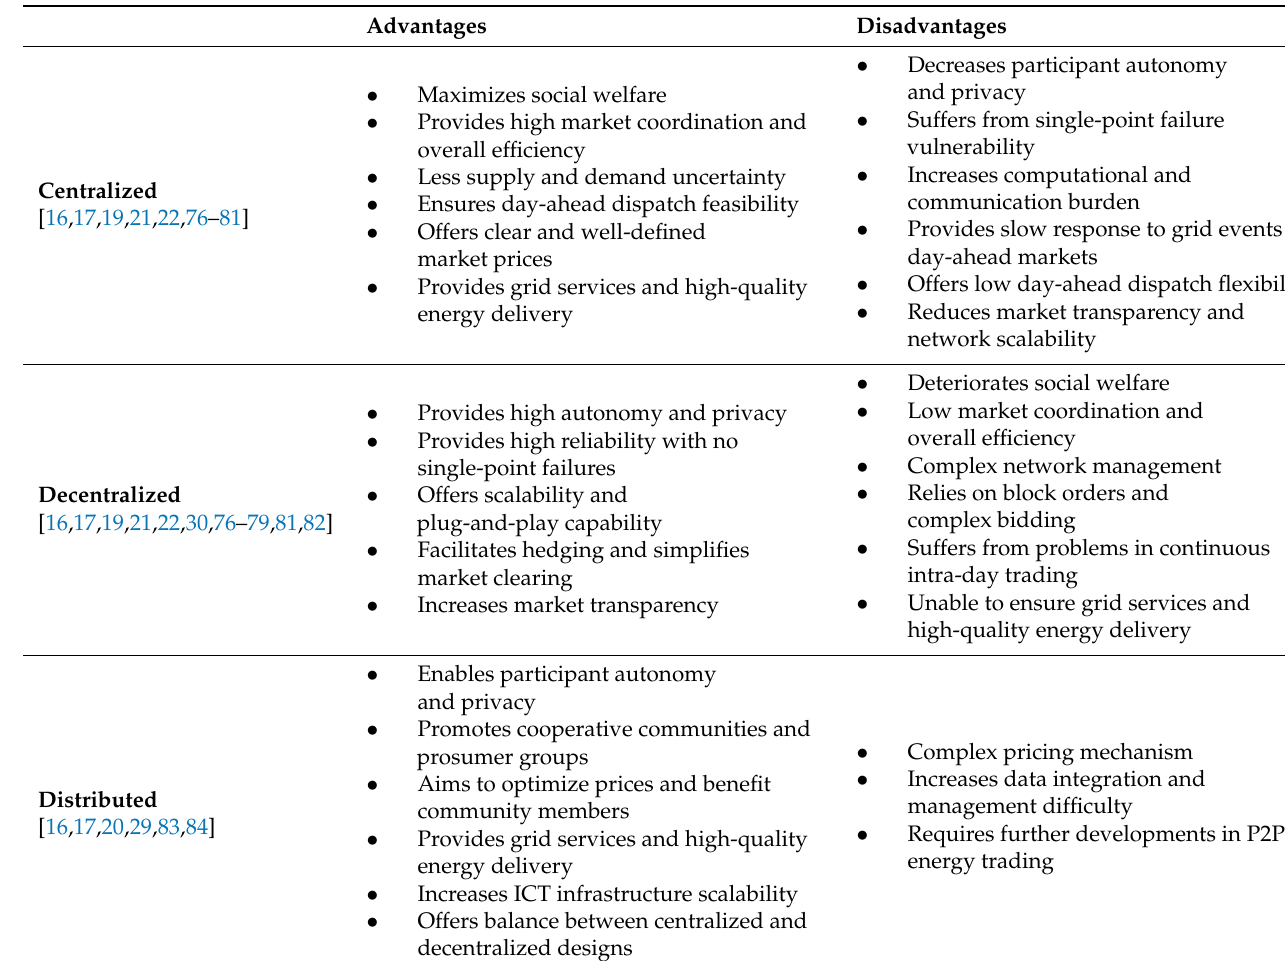
Table 3. Comparison among centralized, decentralized, and distributed market